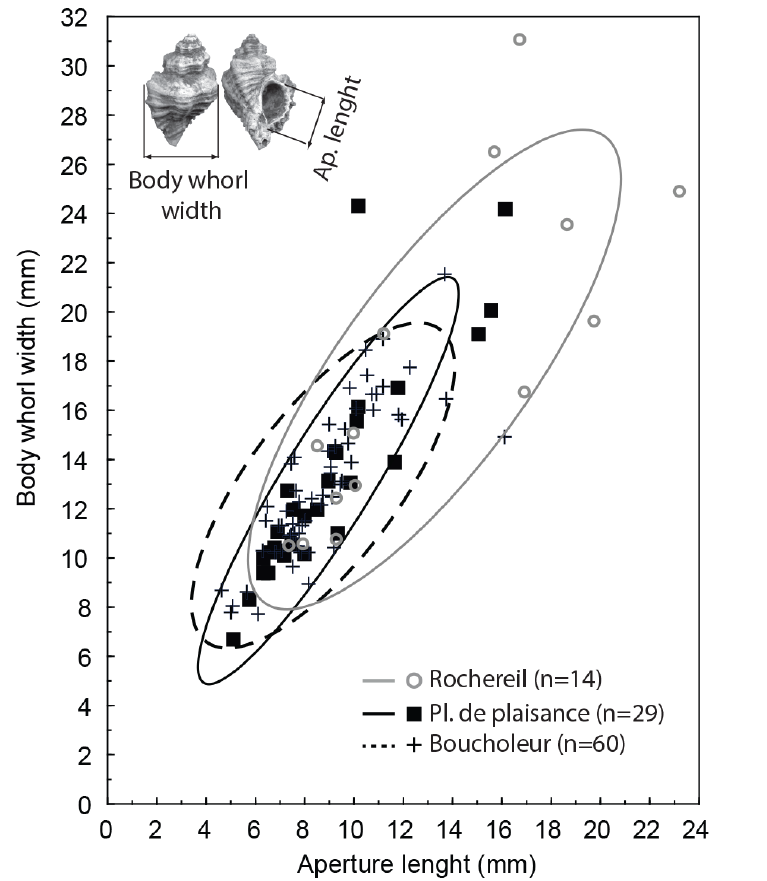
Figure 7 : Scatterplot plot the aperture length and body whorl width registered on the modern reference collections of Ocenebra erinacea and the specimens from Rochereil attributed to the Upper